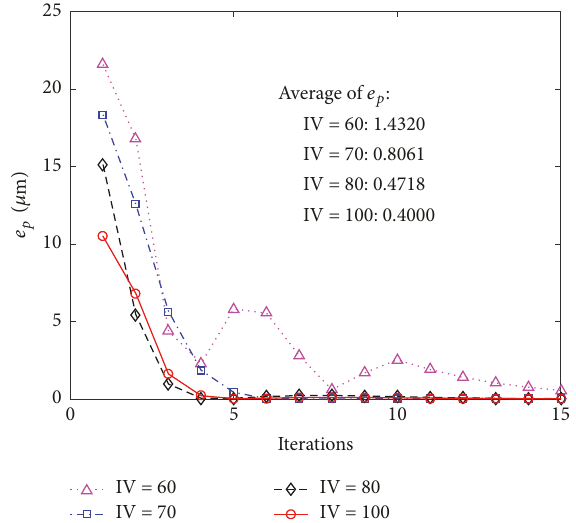
Figure 4: The DLM prediction error profiles of MFAC for different